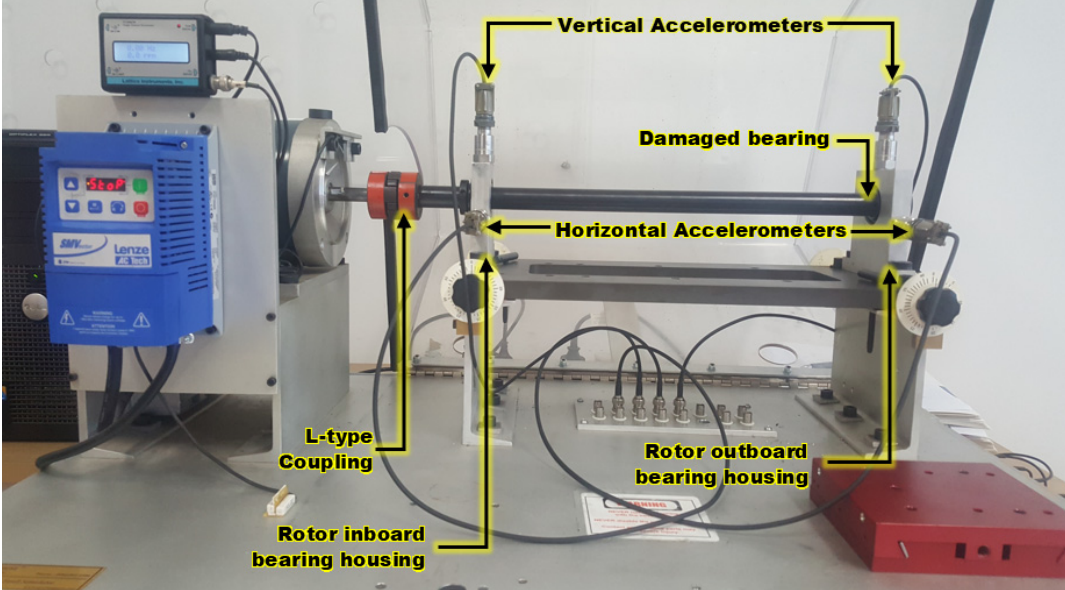
Figure 1. Experimental setup for evaluating bearing damages.